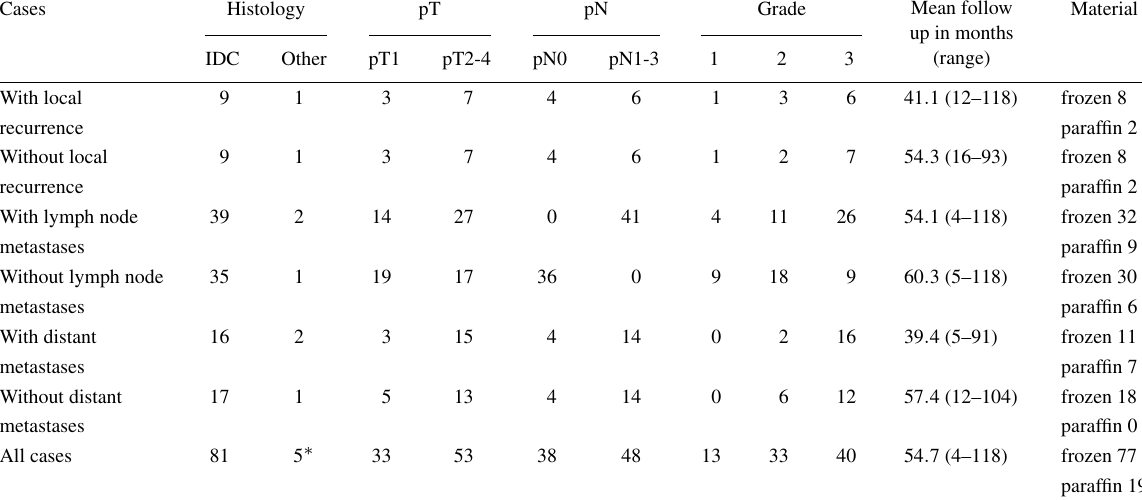
Clinico-pathological characteristics and follow up times of the studied breast